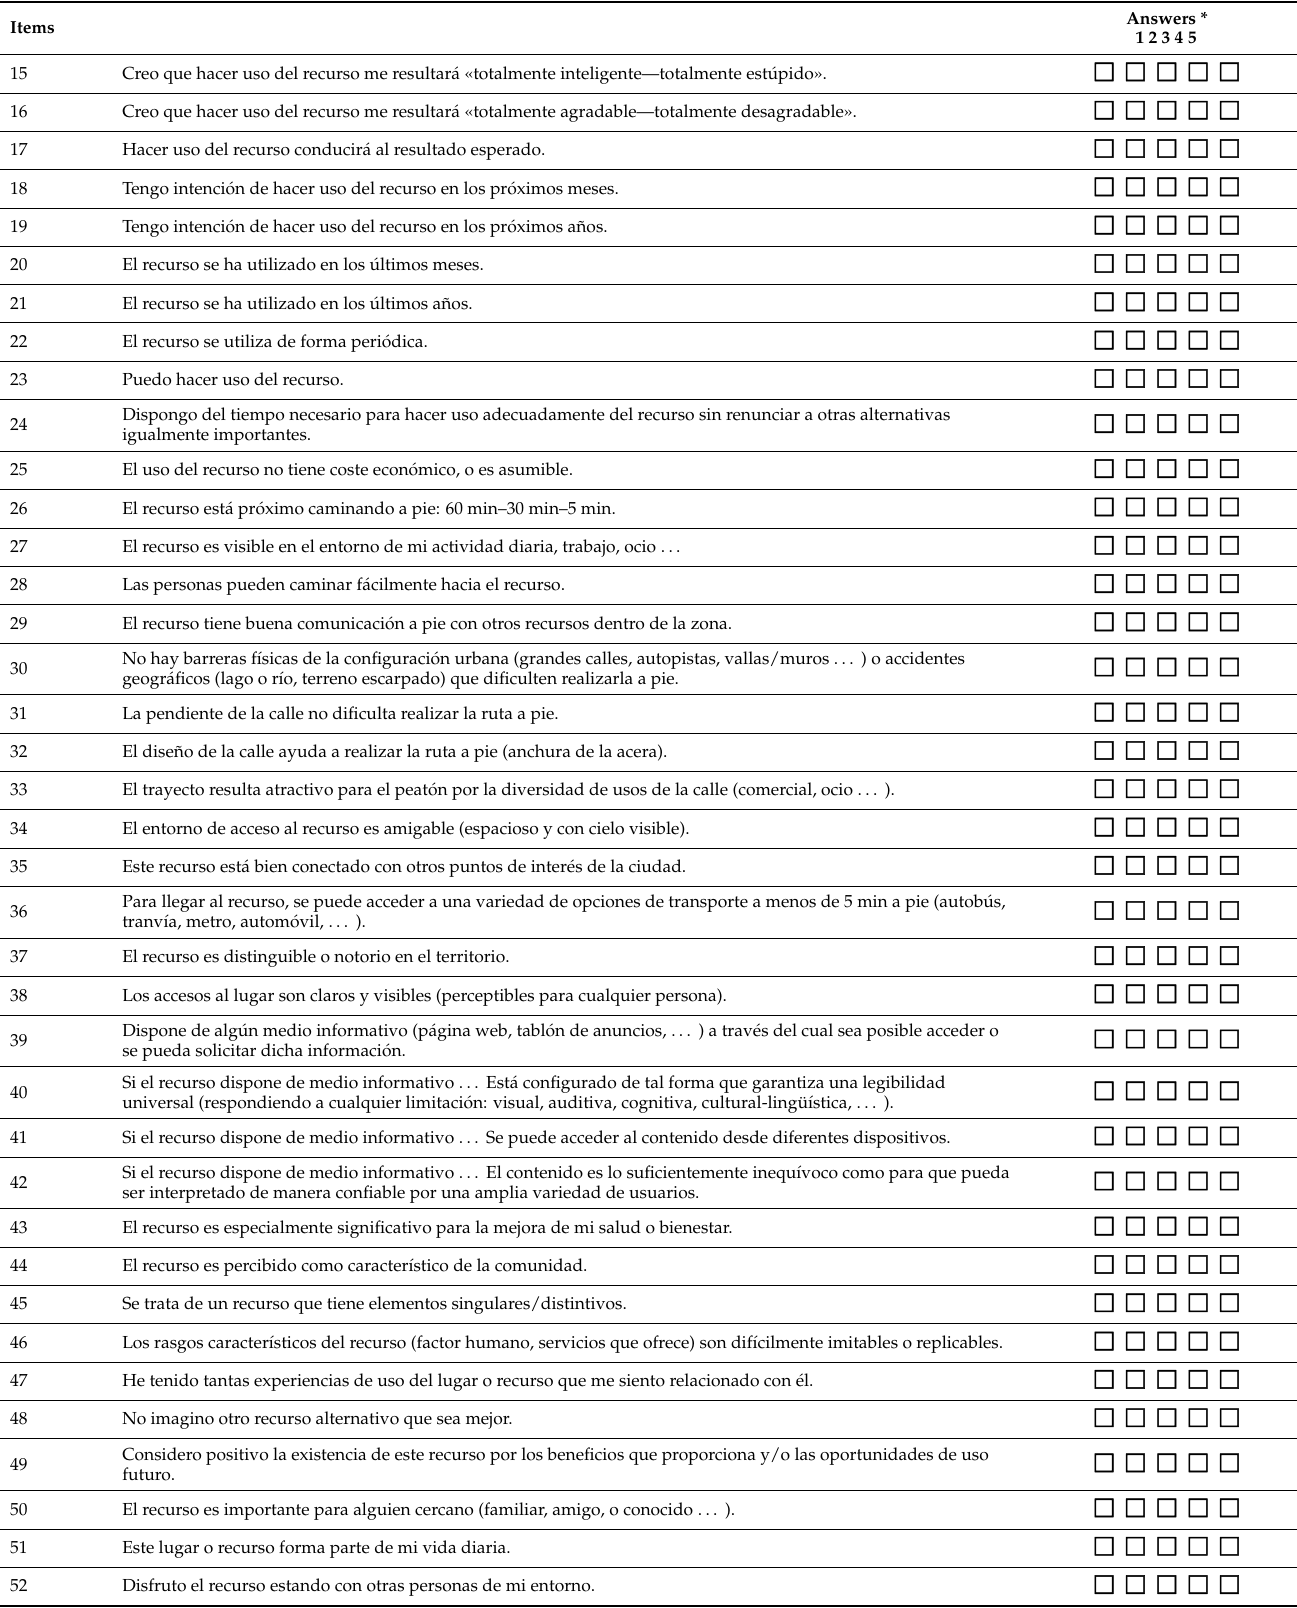
Table A1. Community assets for health assessment scale.